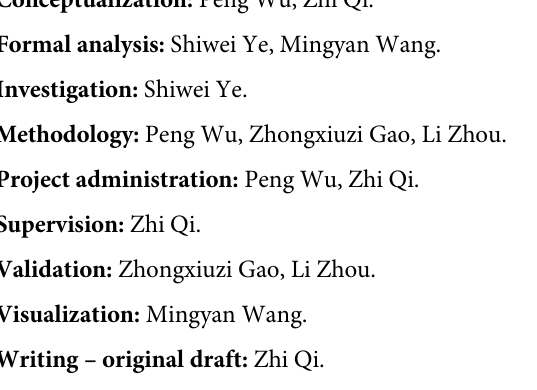
S5 File. Experimental data for Fig 4B. S6 File. Experimental data for Fig 5B. S7 File. Experimental data for Fig